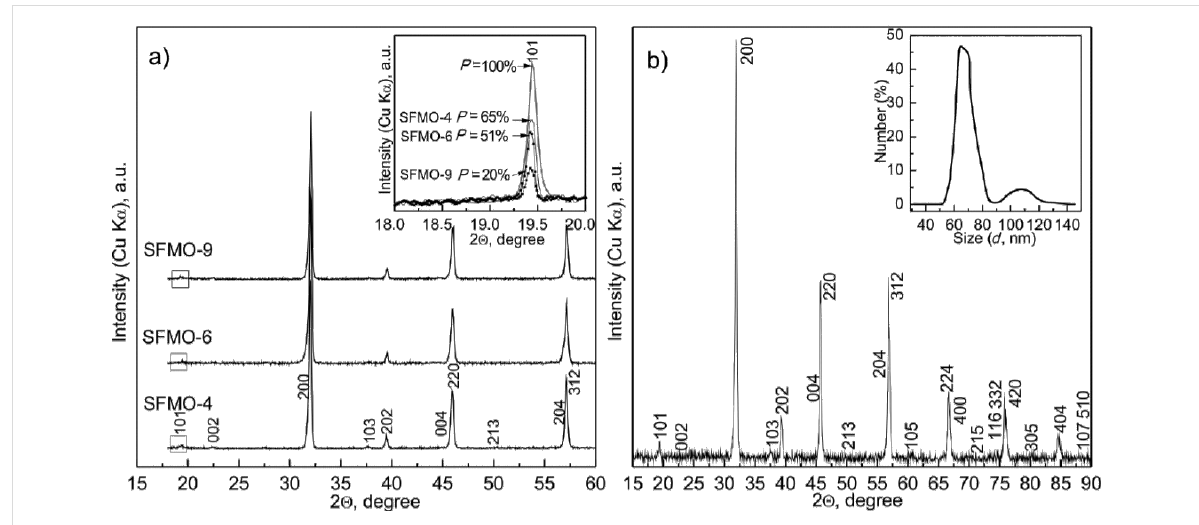
Figure 3: (a) XRD patterns of SFMO-4, SFMO-6, SFMO-9 power samples annealed at 1220 K in a continuous stream of 5% H 2 /Ar gas mixture at 2 K/min. Inset: Estimation of superstructural ordering degree of the iron and molybdenum cations. (b) X-ray diffractogram of Sr 2 FeMoO 6 − x synthe- sized from a colloidal solution at pH 4 with varied annealing conditions (893 K for 1 h, 1060 K for 1 h and 1120 K for 4 h) and hardened at room tem- perature. Inset: Particle size distribution obtained by DLS.